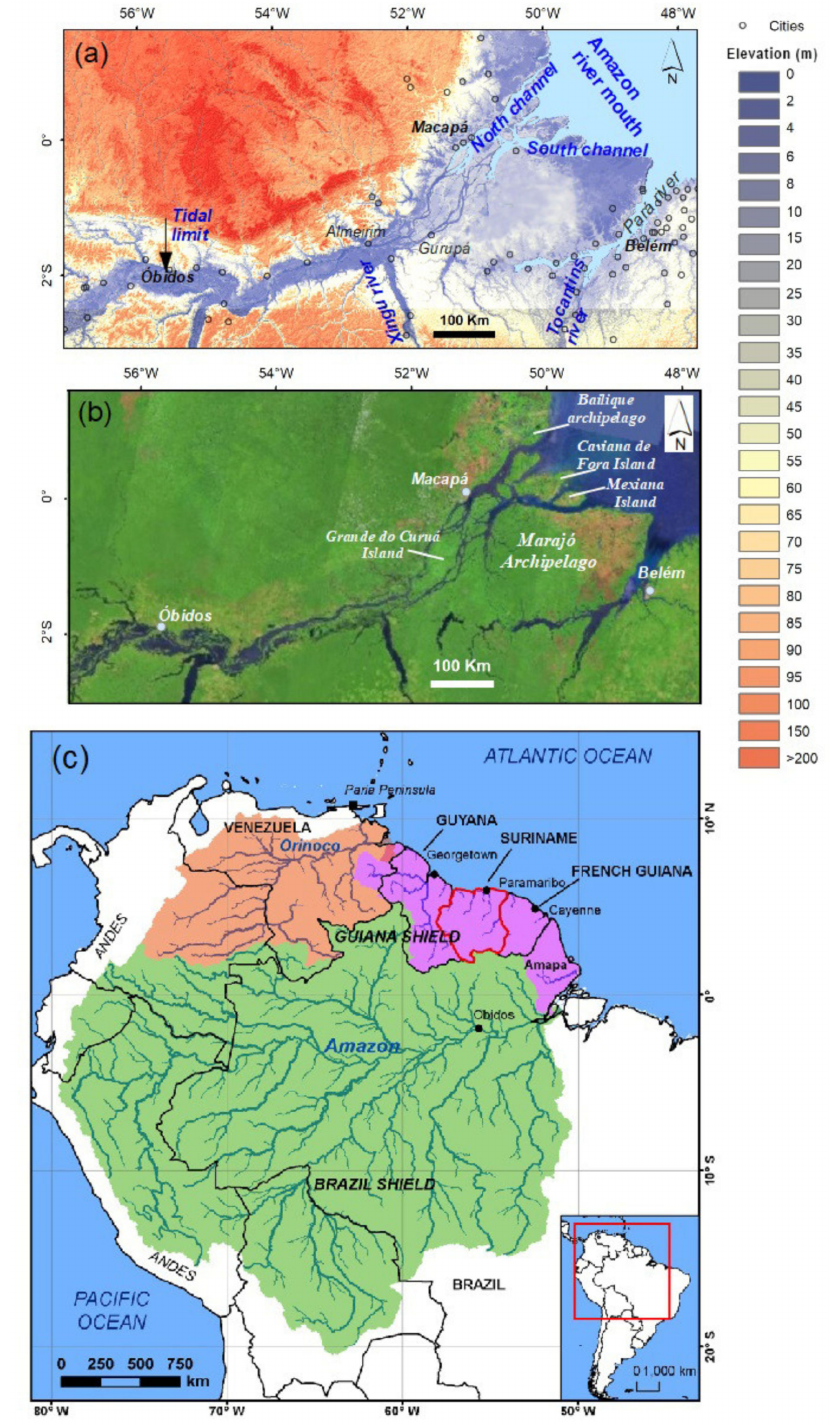
Figure 1. Digital elevation model from ETOPO1 ( a ) and Landsat mosaic (September to November 2017) of the lower Amazon River from Ó bidos to the mouths ( b ); South American setting showing the Amazon River basin (green) and the Guianas countries (purple) influenced by Amazon sediments, including the mouths of the Orinoco River basin (orange) ( c